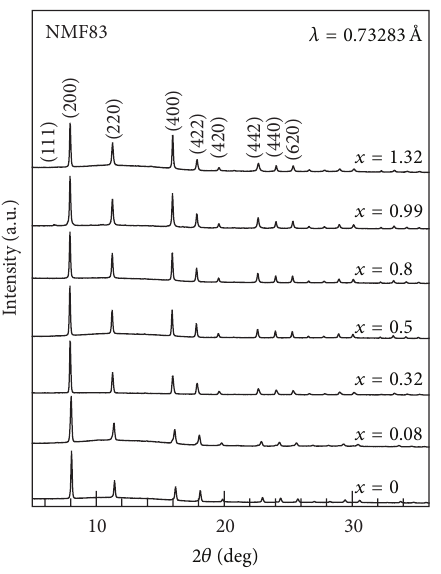
Figure 17: XRD pattern of powered NMF83 against Na concentra- tion( 𝑥 ).Valuesinparenthesesrepresentindexesintheface-centered cubic setting (cited from